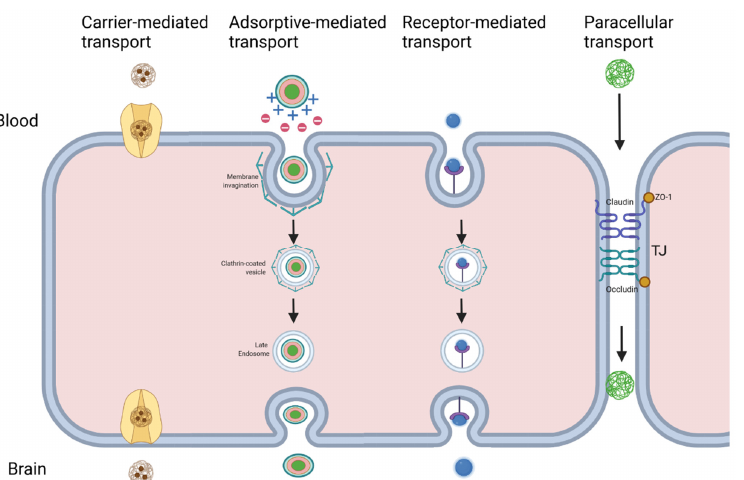
Figure 1. NPs can exploit several transport mechanisms to cross the BBB. Their small size is advan- tageous for paracellular transport across the TJs. Carrier-mediated transport takes advantage of en- dogenous BBB transporters needed for entry of molecules for homeostasis and neuronal health. Ad- sorptive-mediated transport processes occur via favorable interactions between the surfaces of NPs and the endothelial membrane, while receptor-mediated processes stem from recognition of a lig- and on the NP by a membrane receptor. Membrane invagination results in internalization of the NPs into clathrin-coated pits or caveolae before exiting into the target